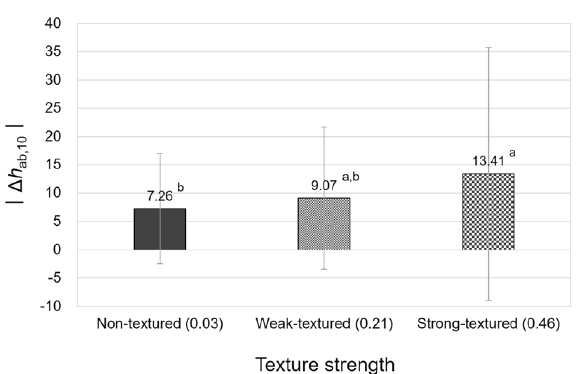
(cid:31) (cid:31) (cid:31) (cid:31) h ab ,10 (cid:31) , under